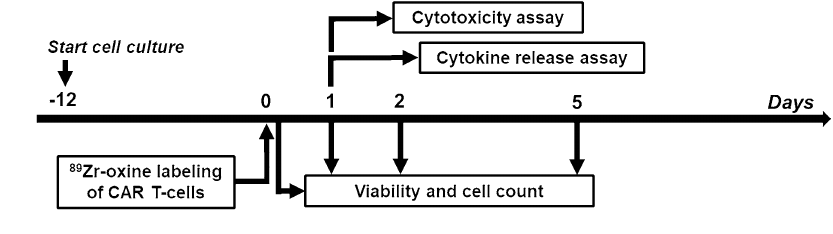
were performed in triplicate samples. The study design for the in vivo experiment evaluating the biodistribution of varying doses of 89 Zr-oxine labeled CAR T-cells is shown in Fig. 1b. Three groups were employed, wherein Raji-bearing NSG mice were randomized to receive a low (n = 3 mice), middle (n = 5 mice), or high dose (n = 3 mice) of 89 Zr-oxine labeled huLym-1-A-BB3z-CAR T-cells. Actual doses administered into mice were as follows: Low dose (126.7 ± 2.5 kBq, 1.87 ± 0.04 × 10 6 cells), Middle dose (542.6 ± 92.1 kBq, 7.14 ± 0.45 × 10 6 cells), and High dose (1491.7 ± 36.1 kBq, 16.83 ± 0.41 × 10 6 cells). Two experimental batches were performed to achieve the sample sizes for the three groups. For each experimental batch, 6 NSG mice were inoculated with Raji cells subcutaneously on the right flank 12 days prior to the administration of 89 Zr-oxine labeled CAR T-cells. For all studies, mice received labeled CAR T-cells intravenously (IV) via the tail vein on day 0. Mice then underwent simultaneous PET/MRI imaging at 3, 24, 48, and 120 h post injection of 89 Zr-oxine labeled cells, corresponding to day 0, 1, 2, and 5, respectively. Regions of interests (ROIs) were dissected on day 6 post-injection and gamma counted for ex vivo biodistribution quantitation. Percent injected dose per gram tissue (%ID/g) for ROIs, such as blood, bone, brain, liver, lungs, spleen, and tumor were derived from in vivo PET images and ex vivo biodistribution. We also calculated the in vivo tumor-to-blood ratio by dividing the tumor %ID/g by the blood %ID/g, to account for the accumulation of cell signal within the extravascular spaces of the tumor excluding signal from the blood vasculature compartment. Primary human T‑cell isolation and CAR T‑cell preparation. Primary human T‑cell isolation. Hu- man primary T-cells were isolated from peripheral blood mononuclear cells (PBMCs), obtained from human